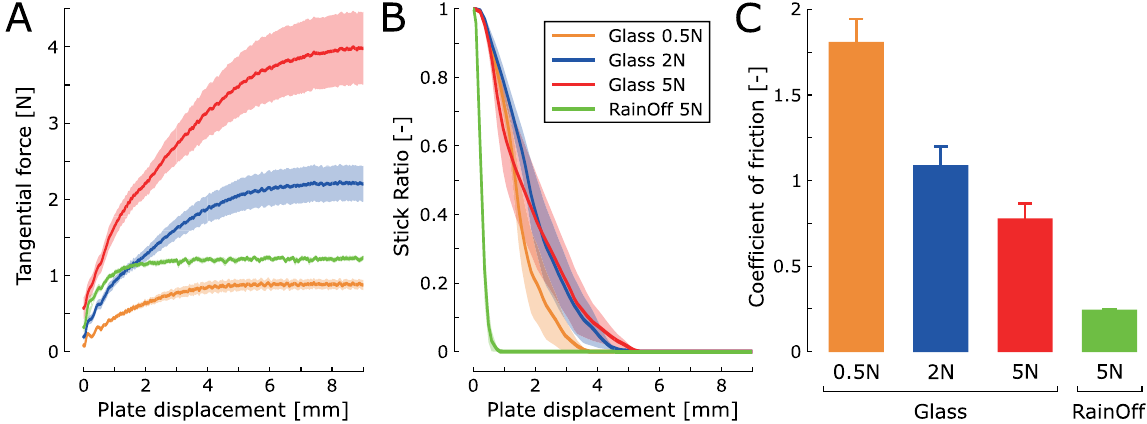
Figure 4. Control experiment testing finger pad mechanics. (A) TF and (B) SR plotted against PD for the following conditions: bare glass with a NF of 0.5 N (orange), 2 N (blue), and 5 N (red), and RainOff-covered glass with a NF of 5 N (green). Data are displayed as mean ± standard error across subjects. (C) Mean dynamic coefficient of friction ± standard error across subjects. Friction differed among all conditions (p <